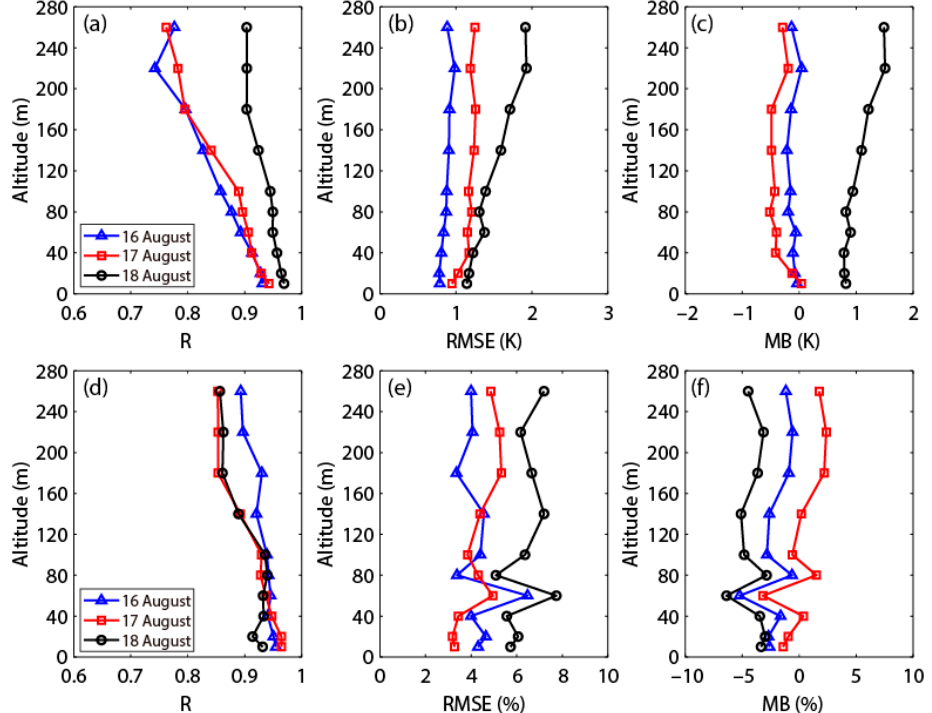
Figure 4. Vertical profiles of ( a , d ) R, ( b , e ) RMSE, and ( c , f ) MB for potential temperature (upper panels) and relative humidity (lower panels) observed using the UAV on August 16 (blue triangle), 17 (red square), and 18 (black circle).